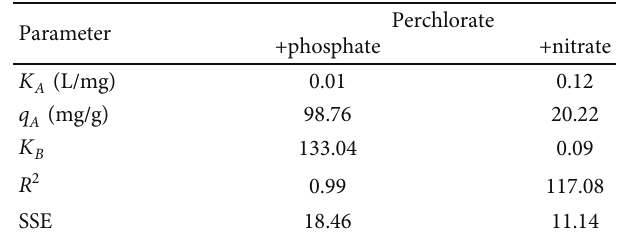
Figure 4: Adsorption fractions and modi fi ed Langmuir models in a binary anion system. (a) Ratio of sorbed perchlorate to sorbed nitrate. (b) Ratio of sorbed perchlorate to sorbed phosphate. For both graphs, MR = 2 : 0 g/L and pH 7 : 0 ± 0 : 5 . Table 4: Modi fi ed Langmuir isotherm parameters for adsorption in the presence of competing